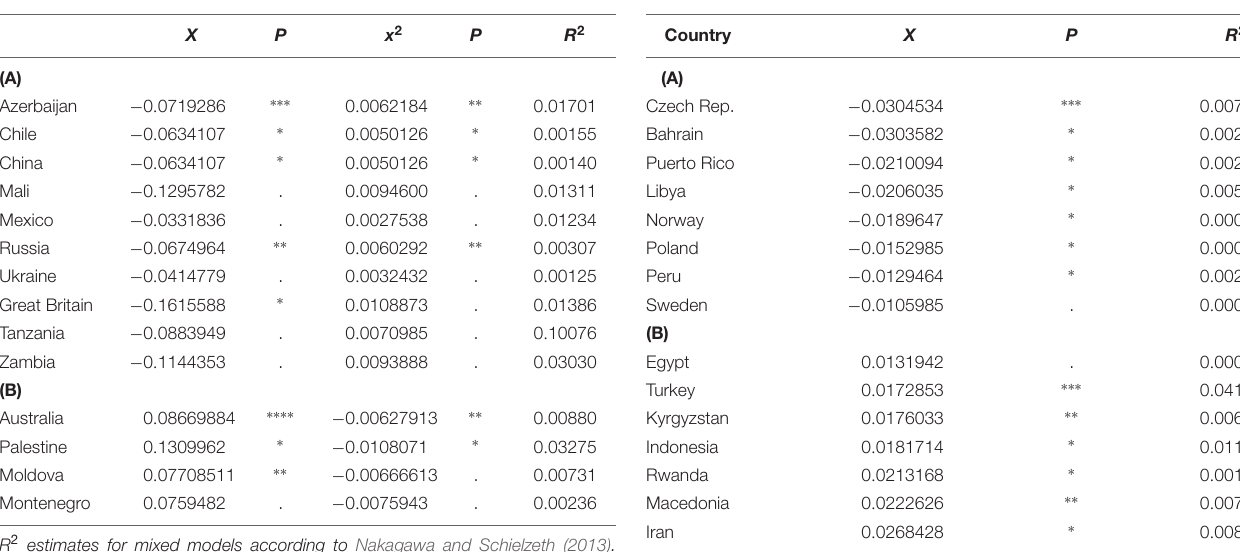
TABLE 3 | Estimates and significances of the linear mixed model of number of children on basis a Poisson error structure regressing on political orientation included as a linear term, age, sex, education (lowest education level 1 as reference), scales of income, and frequency of attendance of religious services, with wave as random factor, separately for single countries of the WVS: (A) political “left” is associated with reproductive advantages and (B) political “right” is associated with reproductive